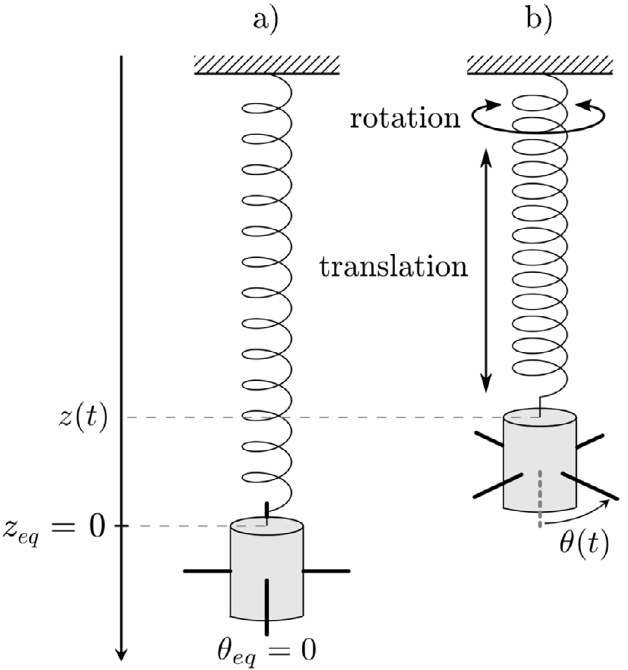
Fig. 1. A sketch of our prototype of the Wilberforce pendulum at its equilibrium state (a) and in motion